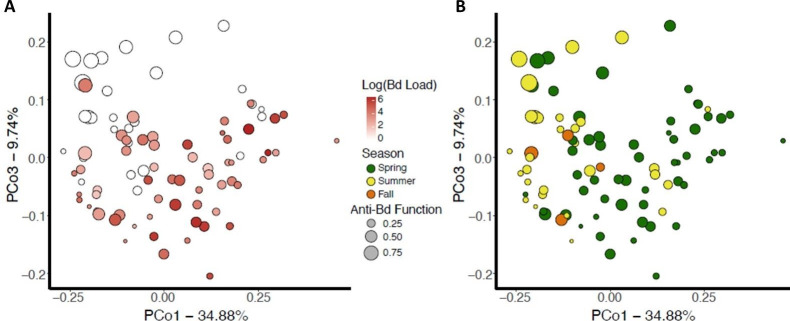
Skin microbiome community structure from wild adult Notophthalmus viridescens (n = 89) was plotted by PCoA of weighted Unifrac distances and examined for patterns with (A) Bd infection load (Uninfected = white to 3*106
= red), and (B) seasonal shifts in the microbiome. Each point represents an individual newt microbiome and is size-scaled based on the relative abundance of predicted Batrachochytrium-inhibitory function. Predicted inhibitory function was greatest in the summer and for uninfected N. viridescens.